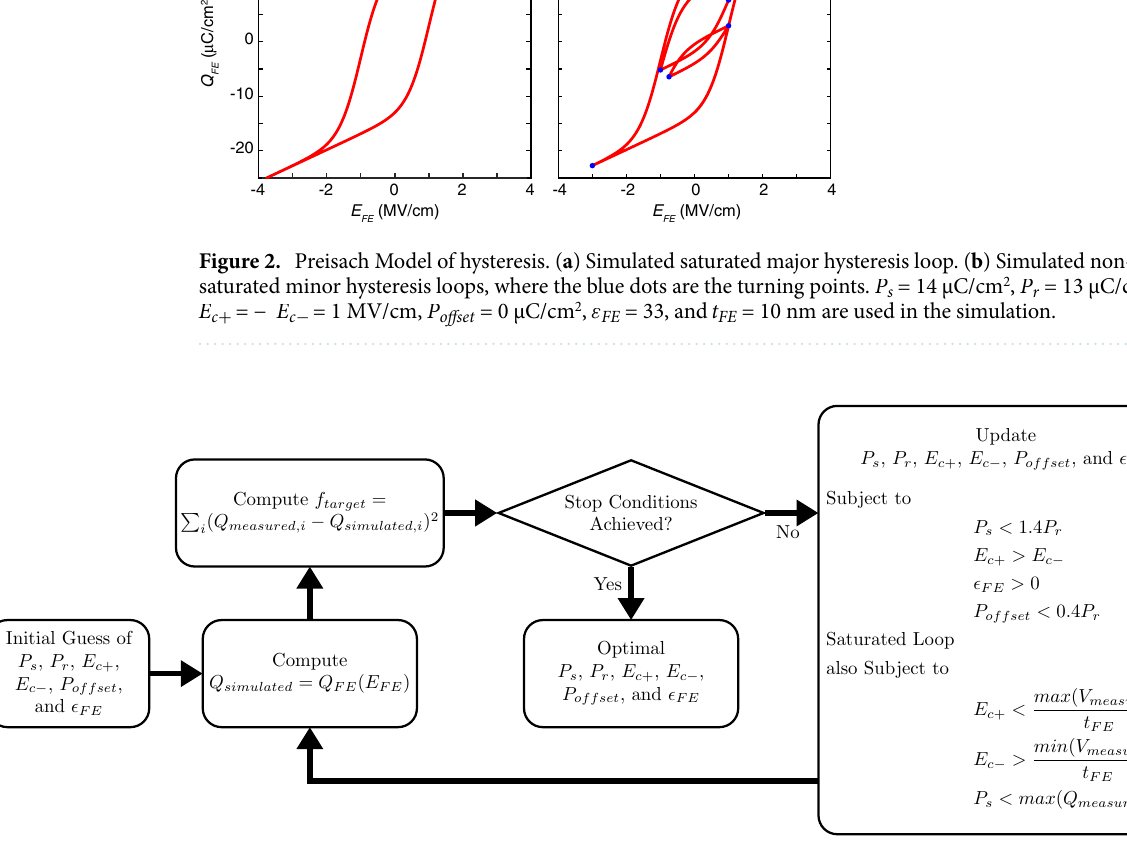
Figure 3. The parameter extraction procedure, where the total squared error between experimental data and simulated results is minimized using the interior-point algorithm 28 under constraints. The optimization process stops when the desired tolerance is achieved or maximum number of iterations is